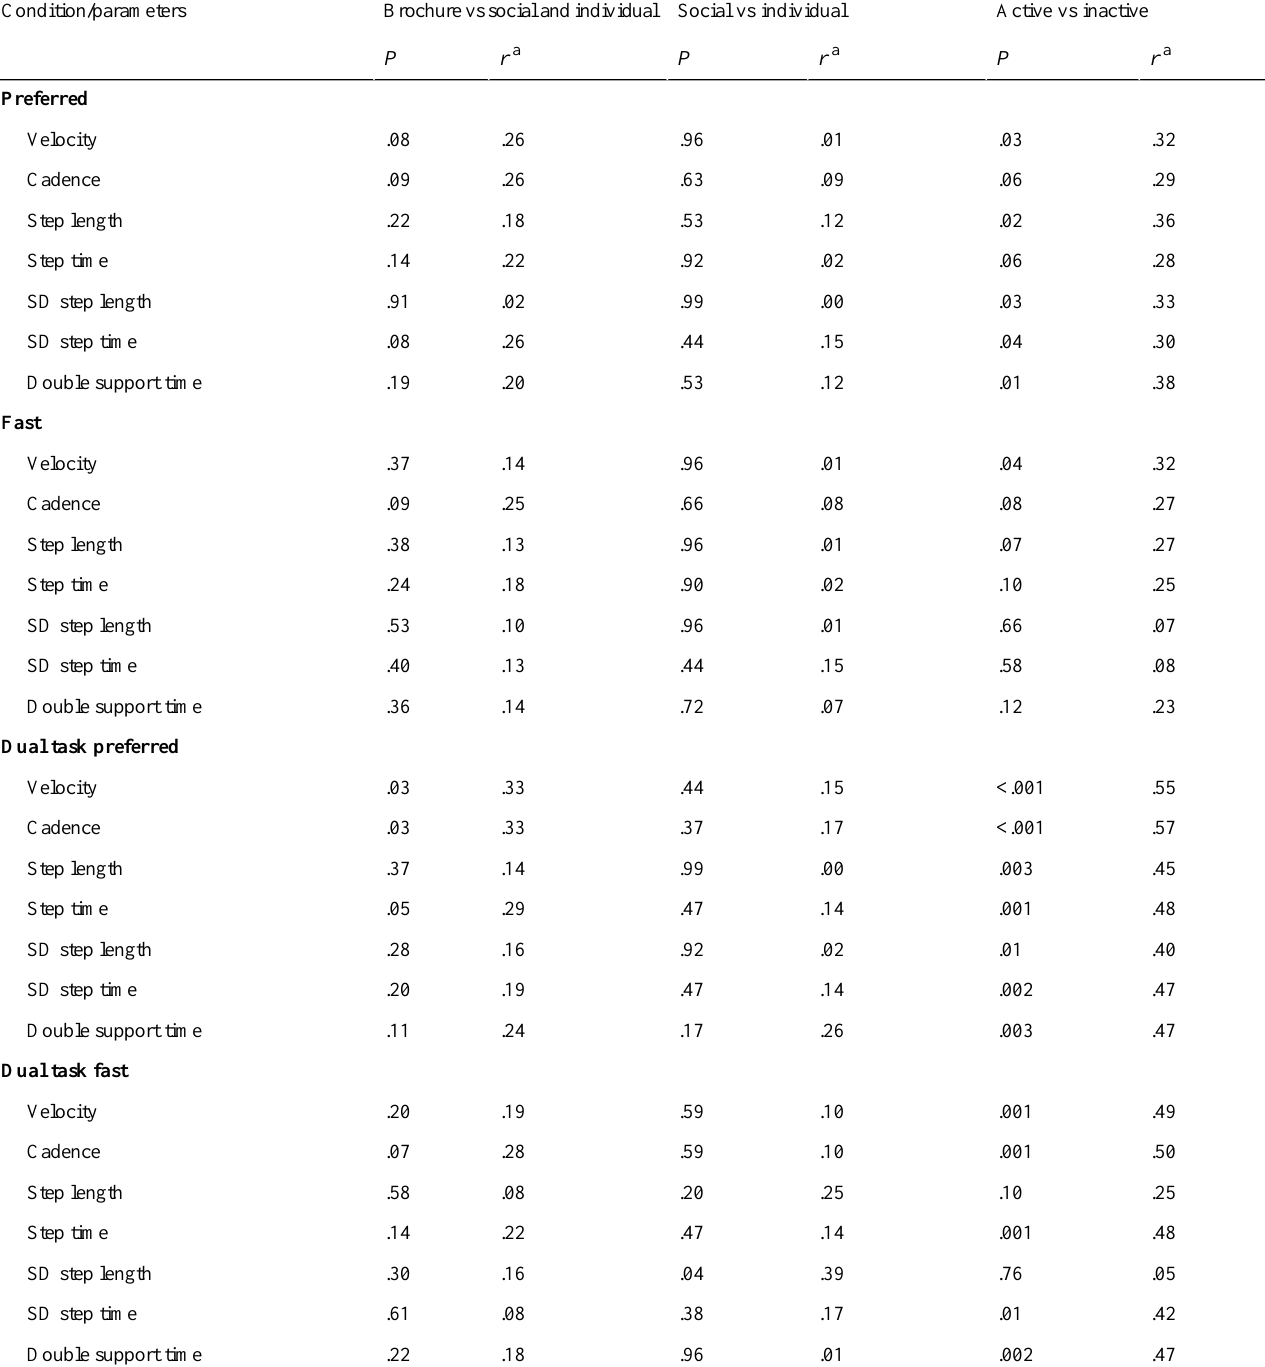
Active vs inactiveSocial vs individualBrochure vs social and